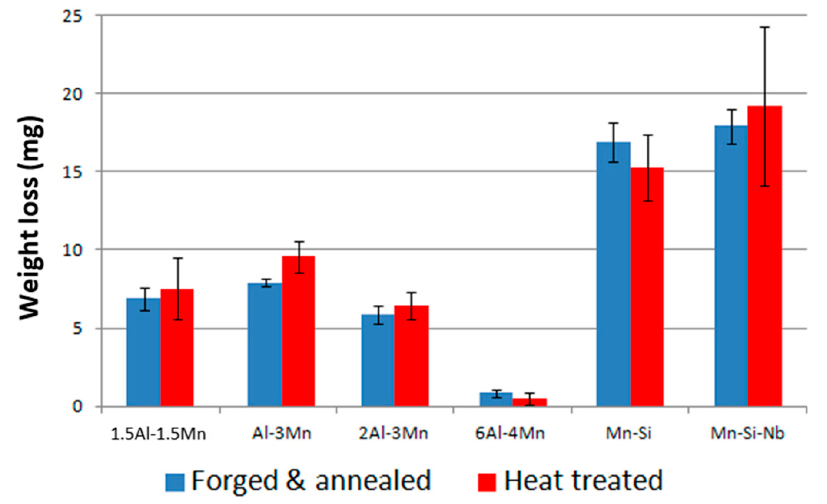
Figure 6. Exposure test—weight loss results.